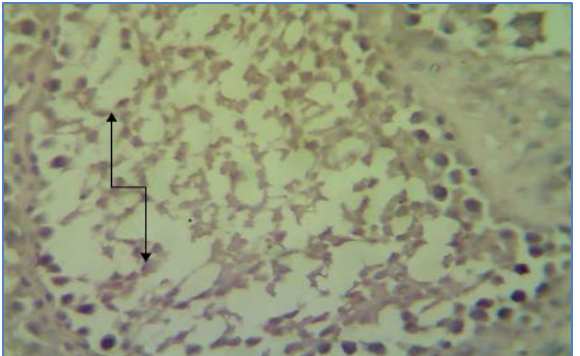
Figure, 12: Section in testis of animal treated with cadmium chloride (G1) shows that seminiferous tubules were loss most of their epithelial layer and filled with fluid and cellular debris ( ) (H and E stain40X).